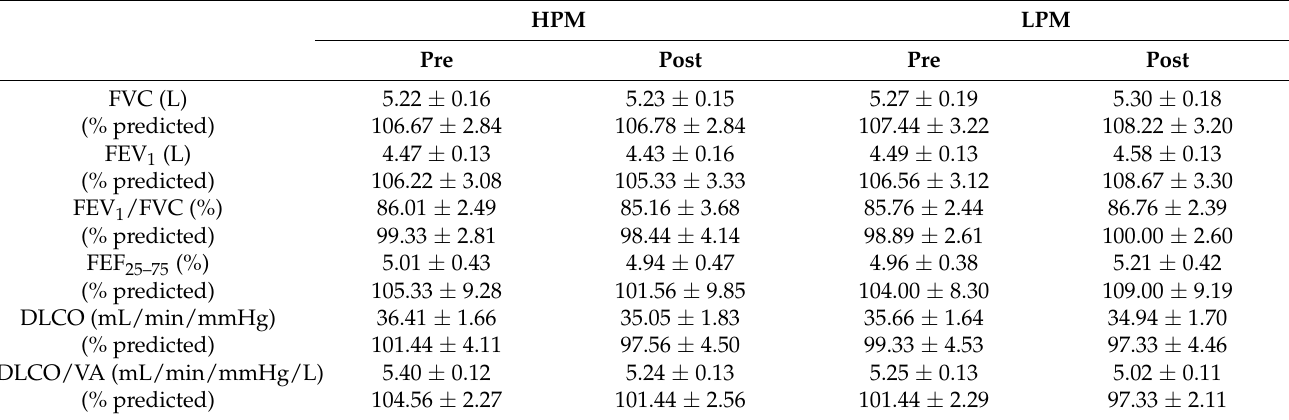
Table 3. Pulmonary function measures at pre- and post-exercise